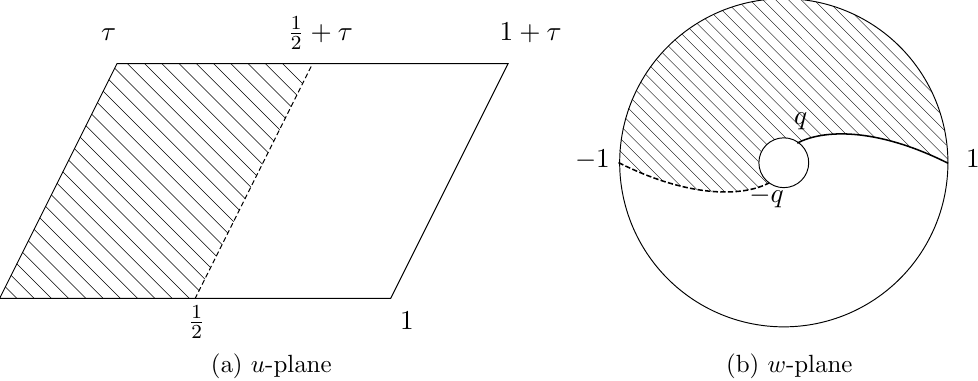
Figure 6. The fundamental domain for the plane (hatched) and its double cover, the torus, in the u and w planes. For the torus, the top/bottom and left/right edges of the diamond in the u -plane are identi(cid:12)ed, and the inner and outer circles in the w -plane (with a twist). The Z 2 further identi(cid:12)es the hatched and unhatched